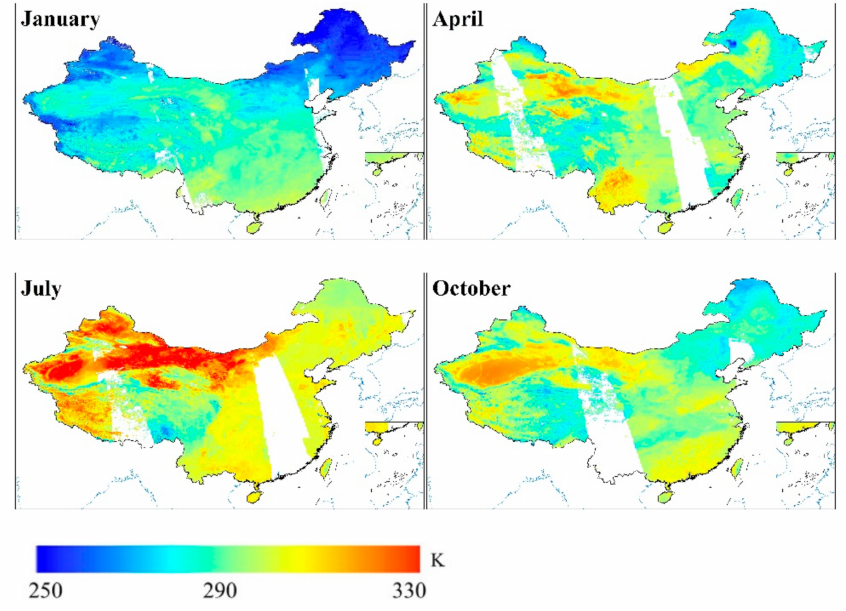
Figure 6. Spatial distribution of the fusion LSTs for daytime of the 17th, 107th, 196th, and 291st days of the year 2010, representing different months.